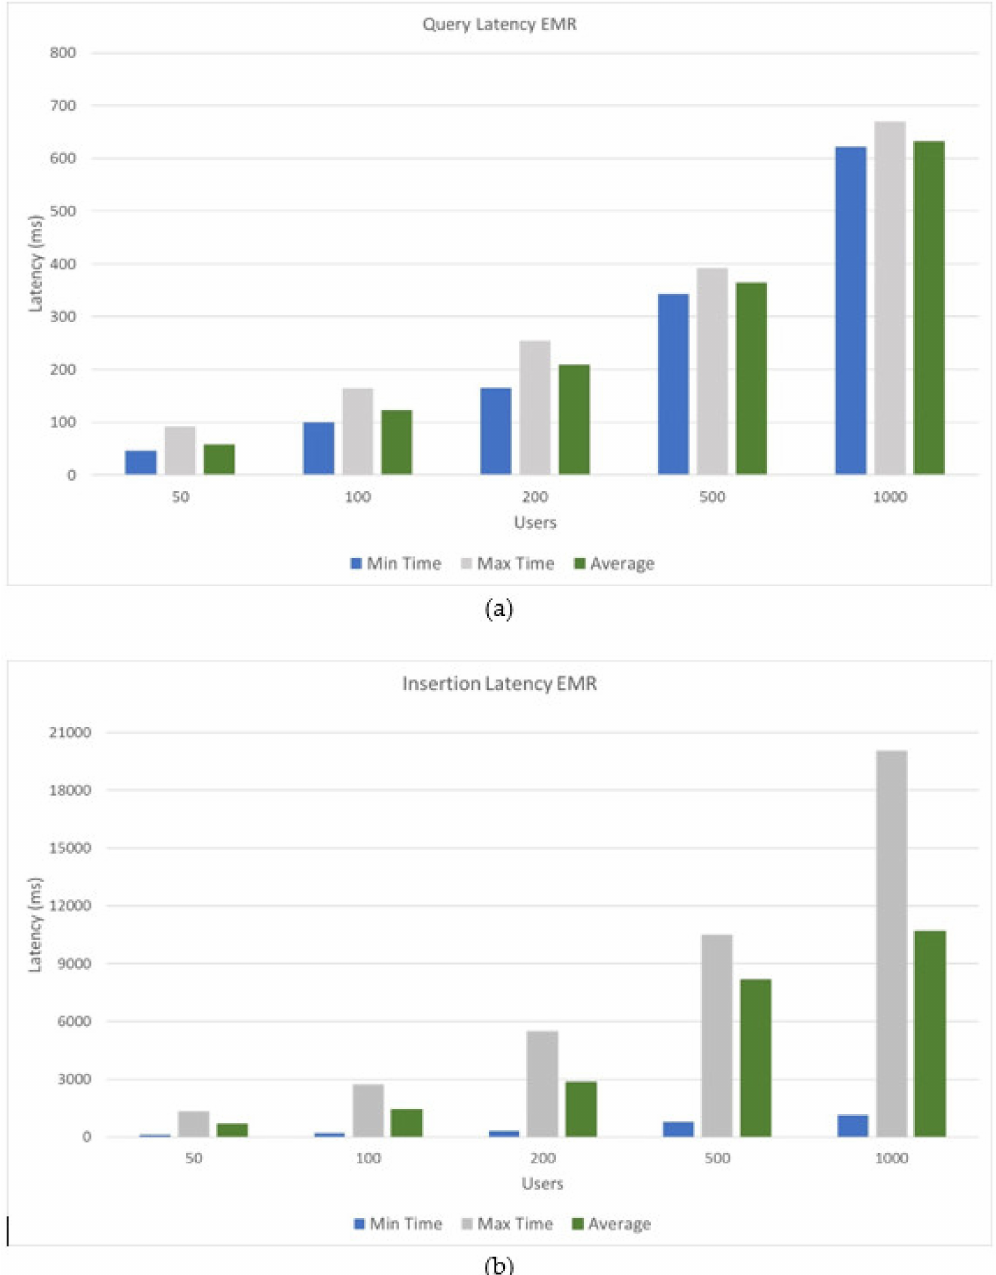
Figure 15. Latency results: ( a ) query latency EMR; ( b ) insertion latency